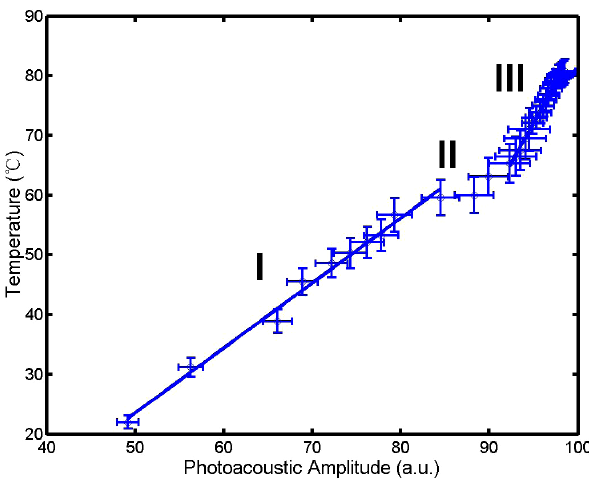
Fig. 4. Temperature versus PA amplitude during the ten- minute exposure of continuous laser light. Temperature in terms of PA amplitude has three distinct parts. In parts I and III, the temperatures are linearly proportional to PA ampli- tude. Part II is the transition part.